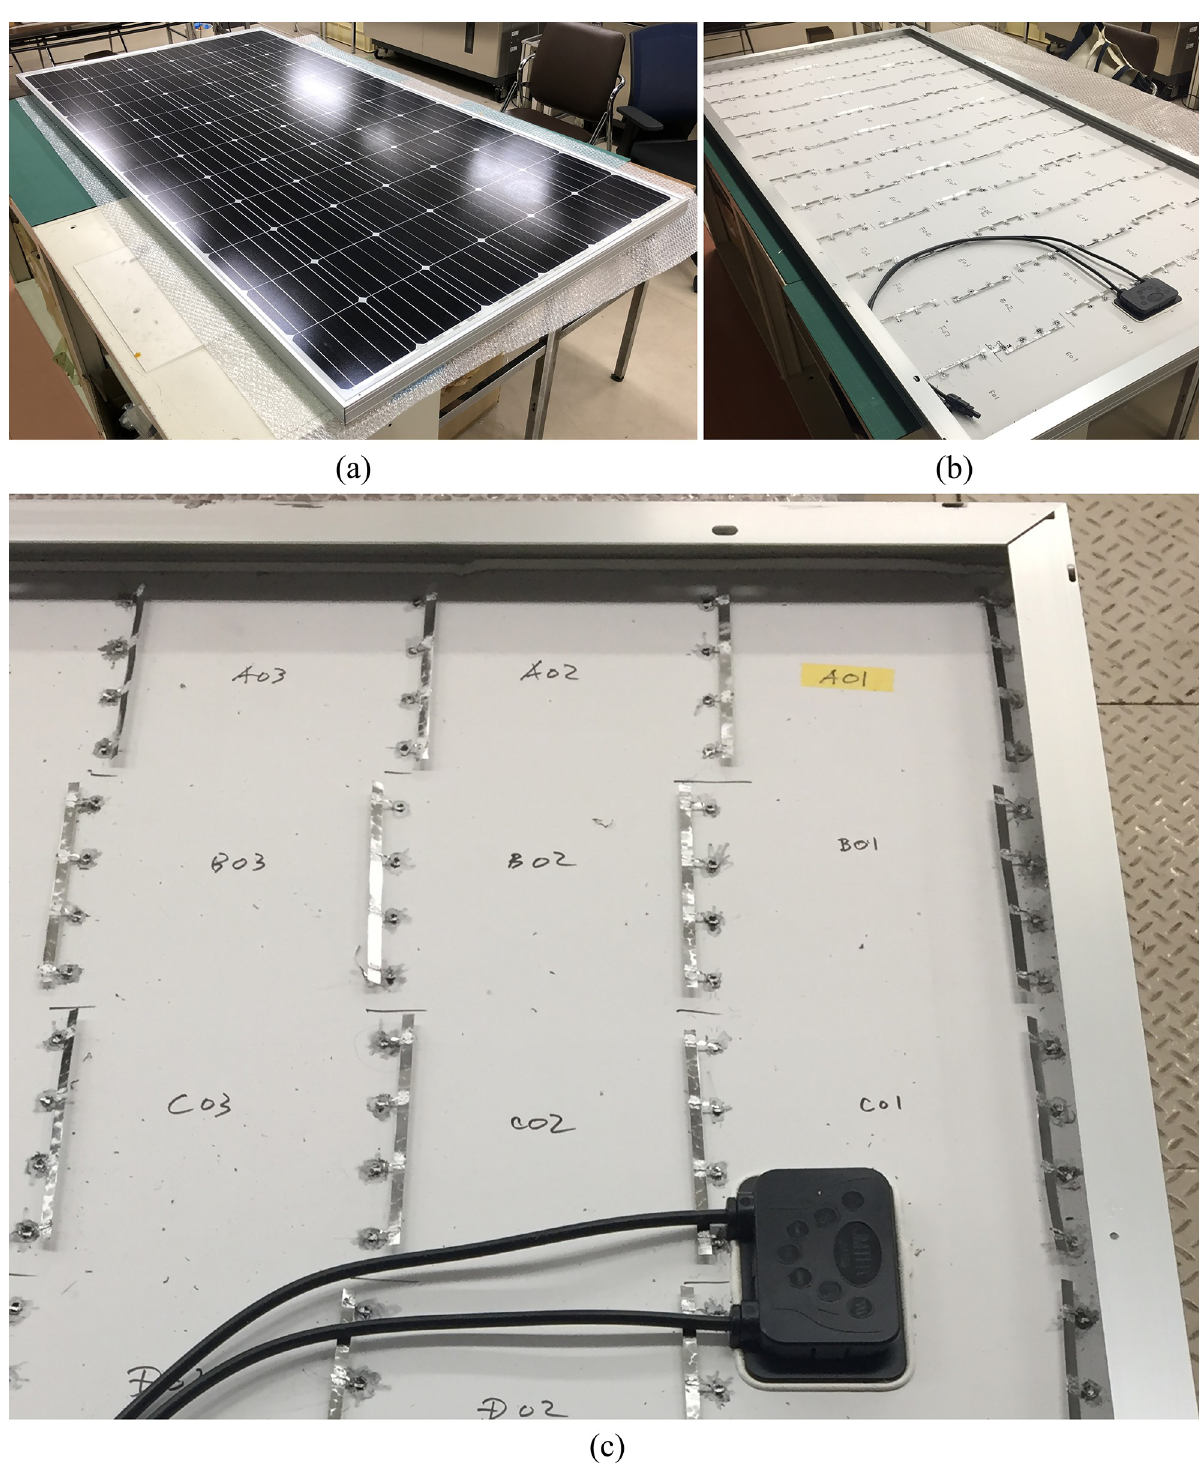
Fig 1. Electrical isolation of individual PV cells in a PV module with cell cracks. Front (a), rear (b), and an enlarged view of the rear (c) of the PV module are shown.